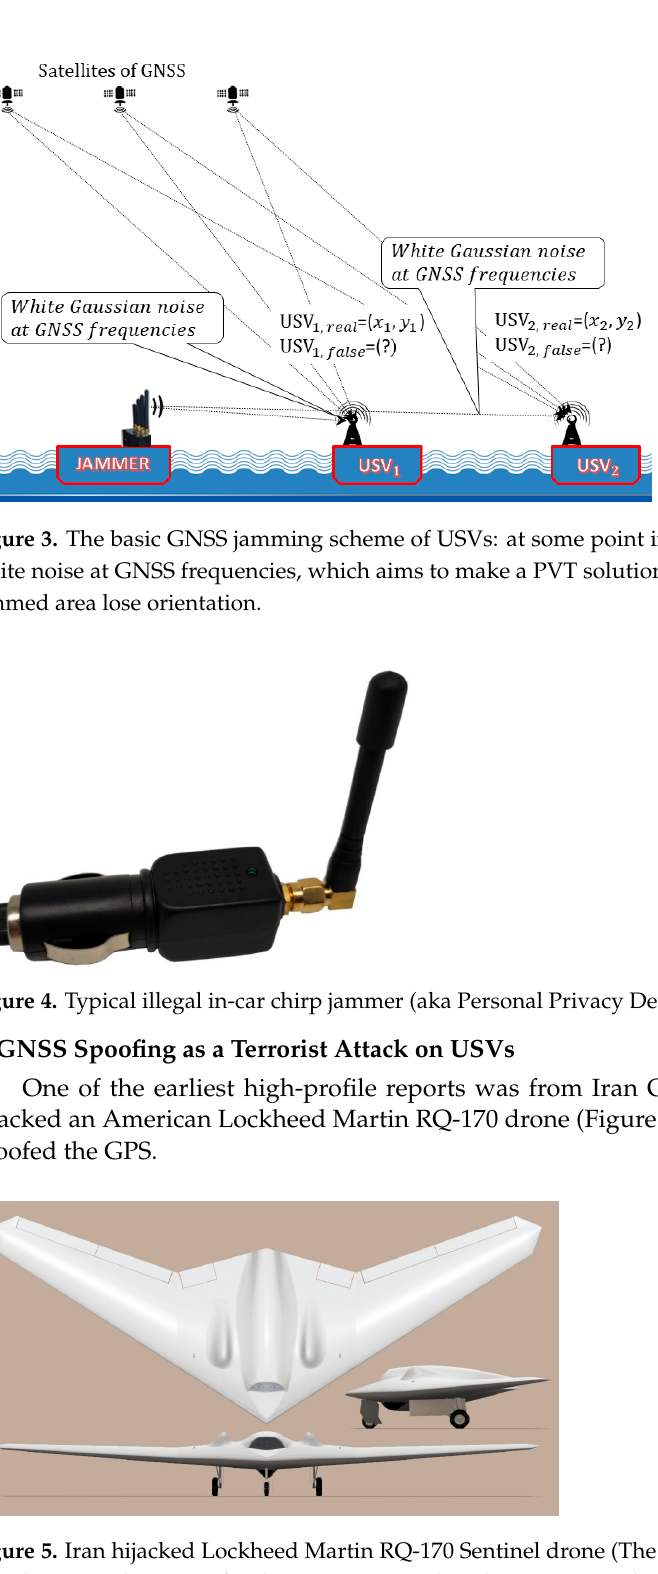
Figure 5. Iran hijacked Lockheed Martin RQ-170 Sentinel drone (The reporting of this incident led to a change in the topic of Łukasz Lemieszewski’s dissertation and to the defence of Poland’s first dissertation “The method of GNSS spoofing detection in terms of transport safety”) [8]. General characteristics: Length: 8 ft 7 in (4.5 m), Wingspan: 38 ft (12 m), Height: 6 ft (1.8